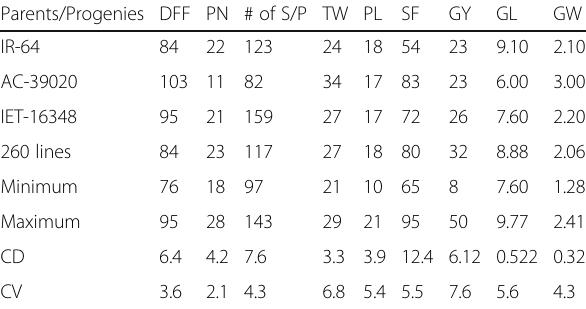
Table 6 Variability in yield and yield-related traits among parents and BC 3 F 3 progenies for under semi-irrigated aerobic